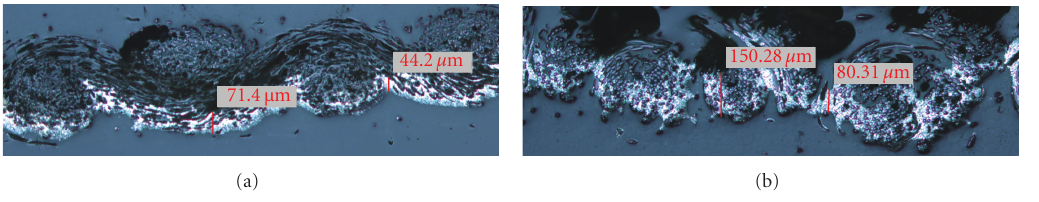
Figure 11: Cross-sections of antennas on Fabric (A) and Fabric (B), washed ten times, magnification is × 20.